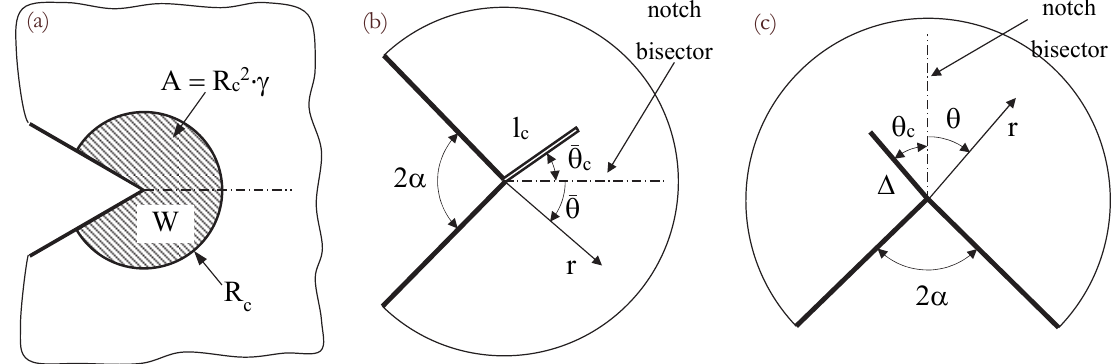
Figure 1: Reference system for: (a) averaged SED criterion; (b) Leguillon et al. criterion and (c) Carpinteri et al. criterion.